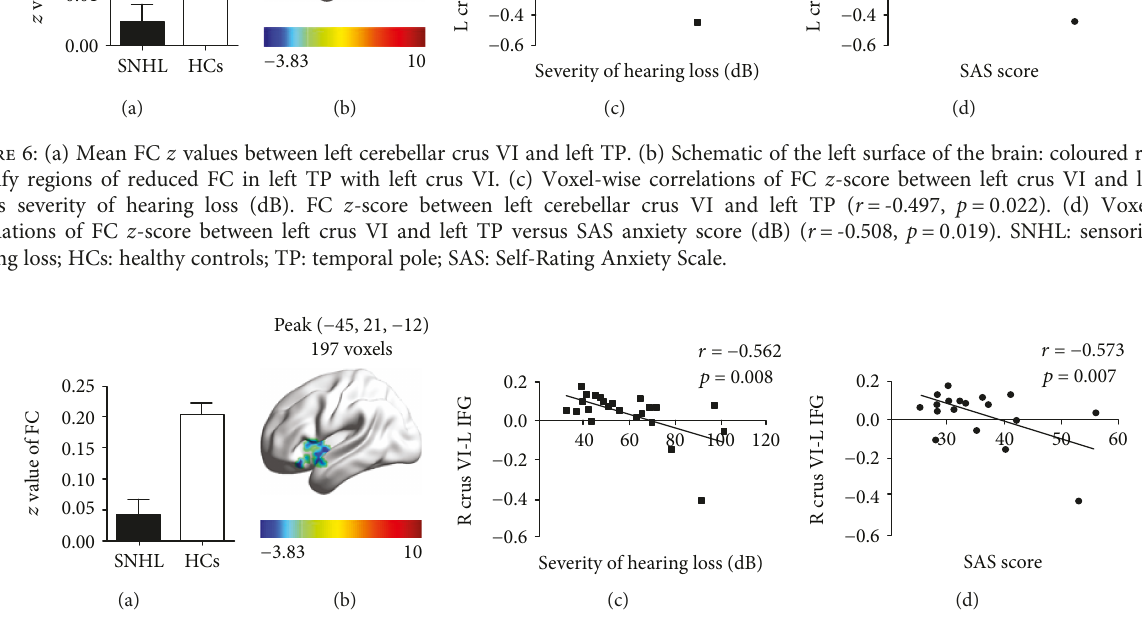
Figure 7: (a) Mean FC z values between right cerebellar crus VI and left IFG. (b) Schematic of the left surface of the brain: coloured regions identify regions of reduced FC in left IFG with right crus VI. (c) Voxel-wise correlations of FC z -score between right crus VI and left IFG versus severity of hearing loss (dB). FC z -score between right cerebellar crus VI and left IFG ( r =-0.562, p = 0 008 ). (d) Voxel-wise correlations of FC z -score between right crus VI and left IFG versus SAS anxiety score (dB) ( r =-0.573, p = 0 007 ). SNHL: sensorineural hearing loss; HCs: healthy controls; IFG: inferior frontal gyrus; SAS: Self-Rating Anxiety